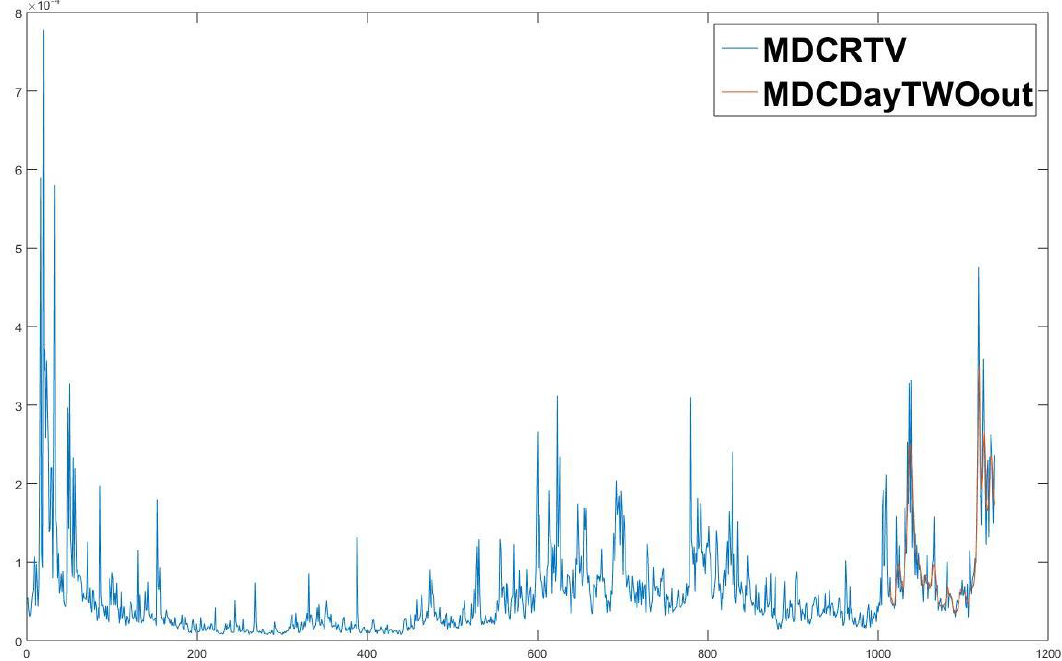
Figure 9. Model TWO-RTV-D Forecast for MDC. The horizontal line is the timeline, and the perpendicular line is the volatility estimator. The forecasted period is the last 124 days. The actual values are represented by the blue line, while the forecasted values are represented by the orange line. The forecasted values are close to the actual values, although there is a sharp jump around the Day